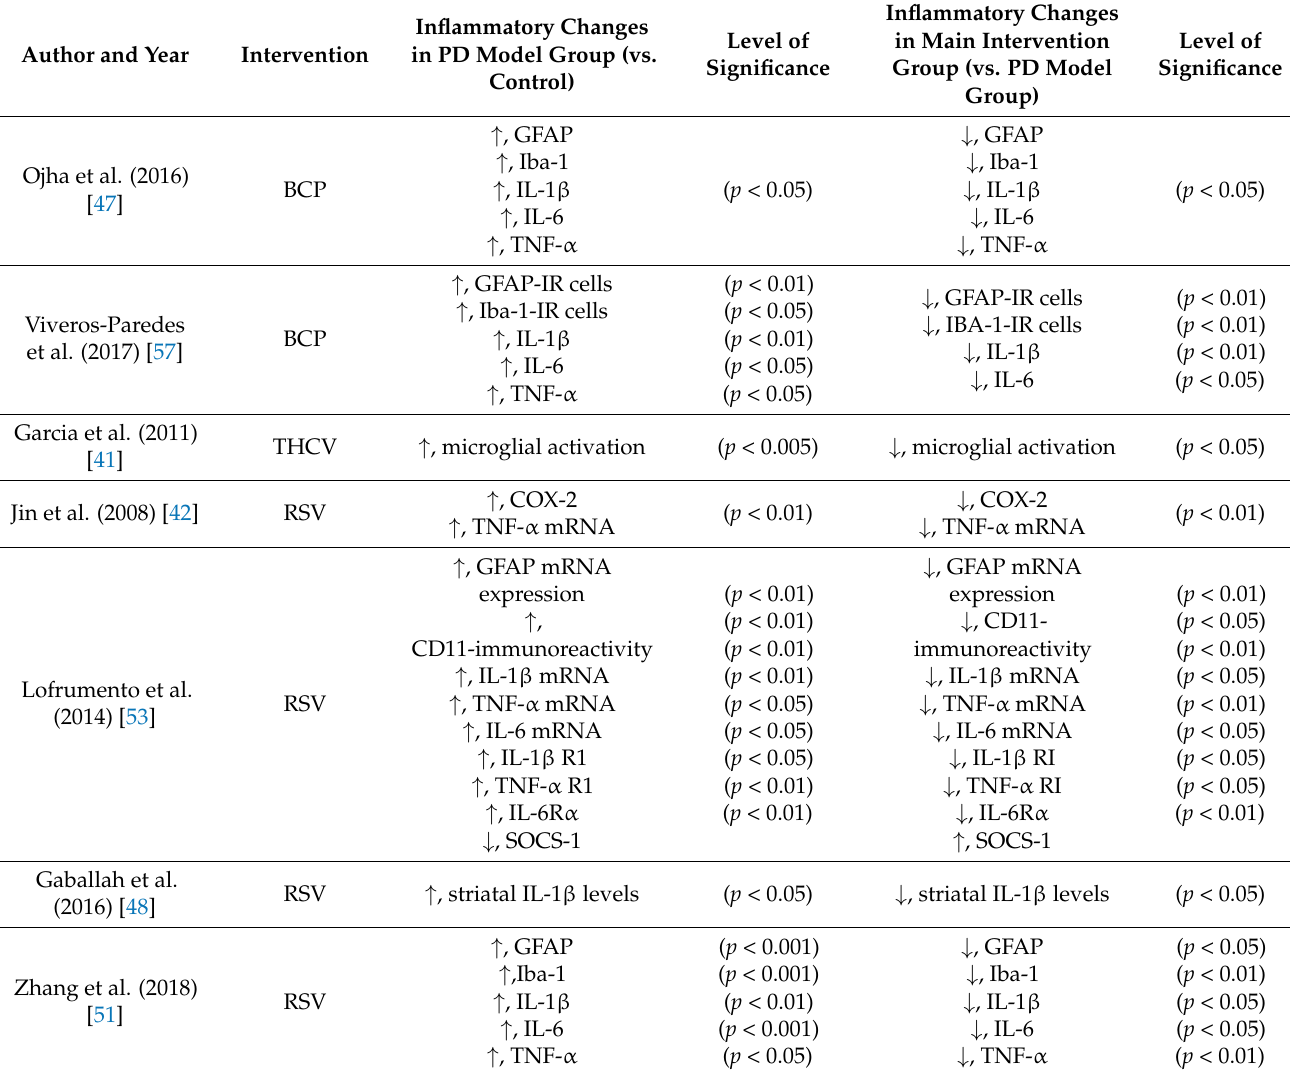
Table 6. Summary of biochemical and immunohistochemical analysis for inflammatory mediators in PD model groups and